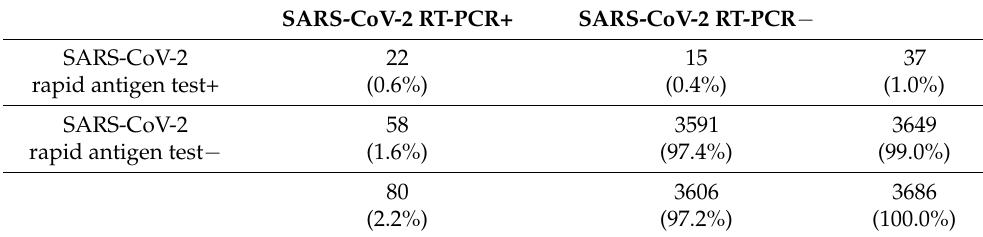
Table A1. Agreement between rapid antigen test and RT-PCR.